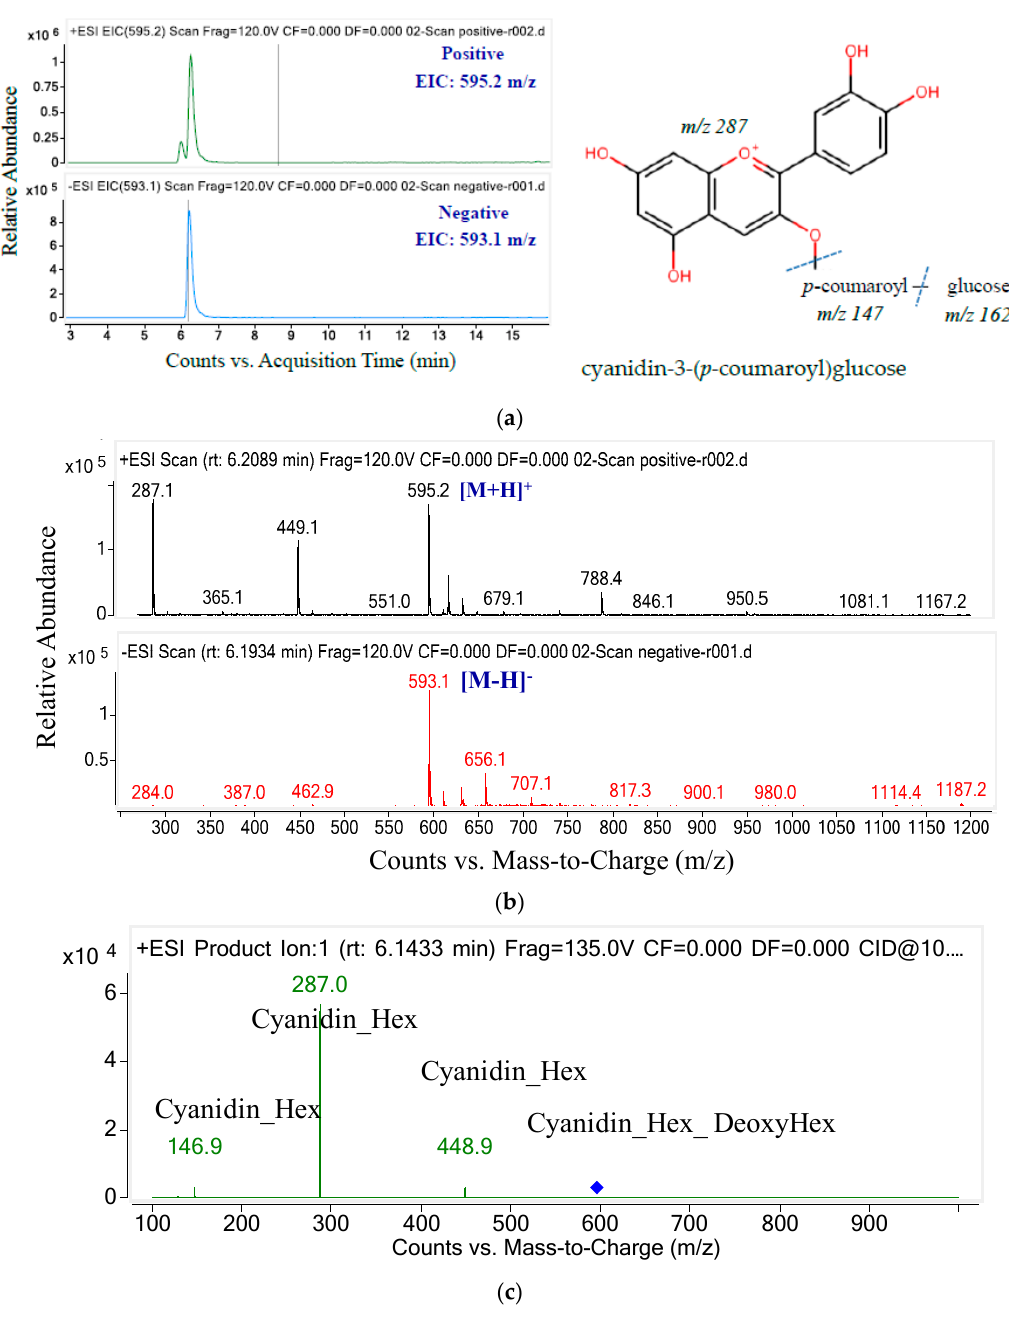
Figure 6. The ion chromatograms ( a ) and ion spectra ( b ) and MS/MS fragments of parent mass 595.2 ( c ).